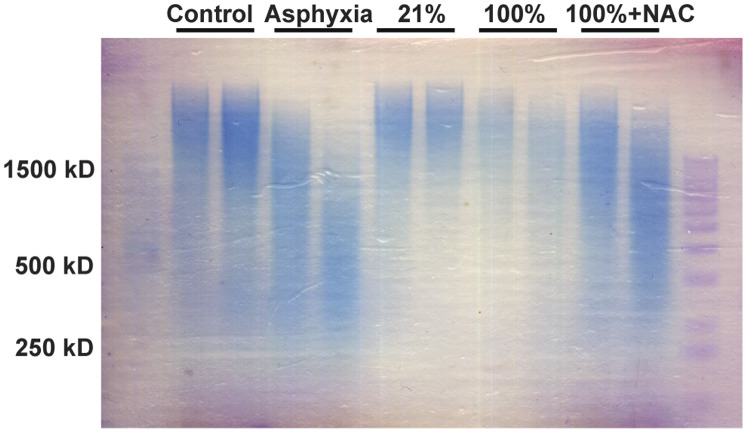
HA size determination.HA size was determined in lung tissue and two representative samples per group are shown in this gel. Control animals had HMW HA and asphyxia was associated with some degradation of HA. Resuscitation with 21% O2 was associated with HMW HA where as resuscitation with 100% O2 showed marked degradation of HA. Interestingly, treatment of 100% O2 resuscitated animals with NAC was associated with a preservation of HMW HA.